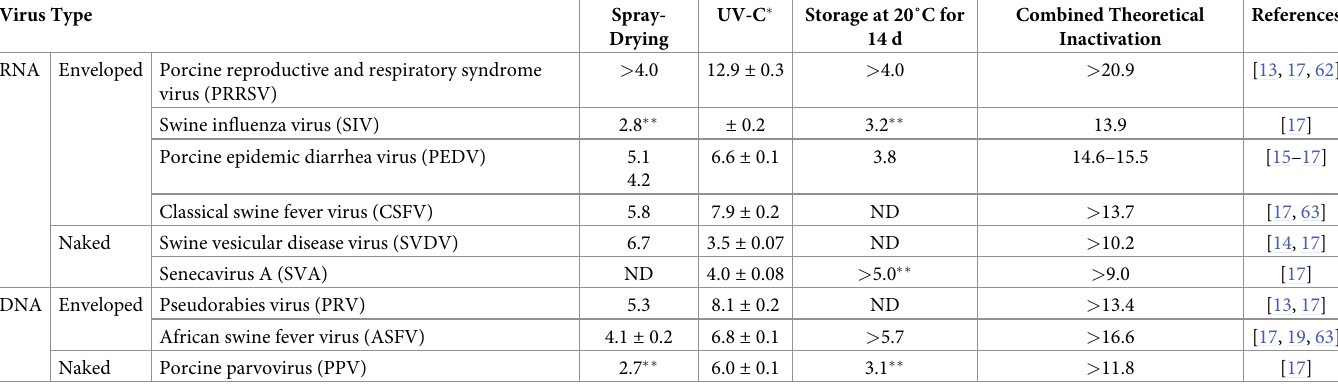
Table 1. Different inactivation steps involved in the manufacturing process of spray dried porcine plasma. Inactivation expressed as log 10 reduction values (LRVs) TCID 50 /g for